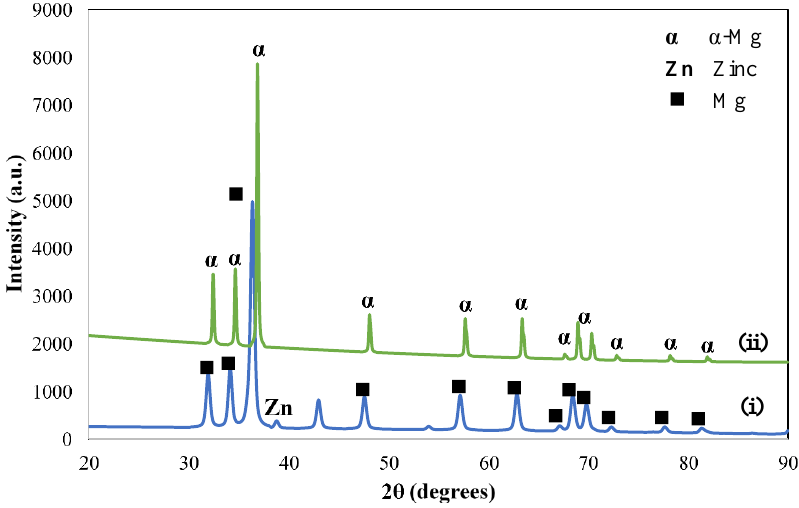
Figure 4.5: XRD patterns of (i) as-milled and (ii) sintered Mg-Zn (PM). Figure 1. XRD patterns of ( i ) as-milled and ( ii ) sintered Mg-Zn. Figure 1. XRD patterns of ( i ) as-milled and ( ii ) sintered Mg-Zn.